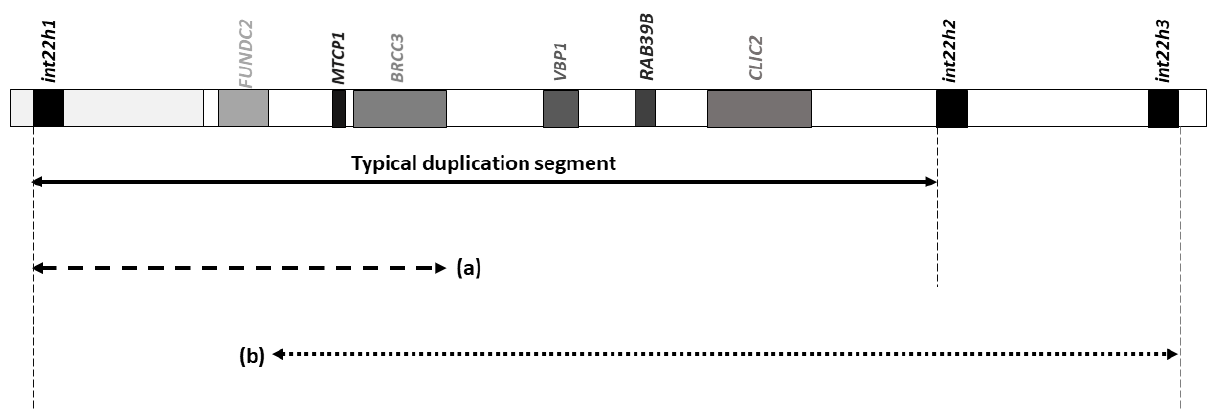
Figure 1. Schematic illustration of the duplicated chromosomal segment in int22h1/int22h2 -mediated Xq28 duplication syndrome. The figure highlights the classical duplication detected in most patients diagnosed to date with the syndrome, as well as two atypical duplications recently detected: ( a ) a shorter duplicated segment that spans only the centromeric half of the typical duplication (~0.26 Mb), identified in a male subject, and ( b ) a 0.2 Mb-telomerically shifted duplication extending beyond the int22h2 locus, detected in two siblings.